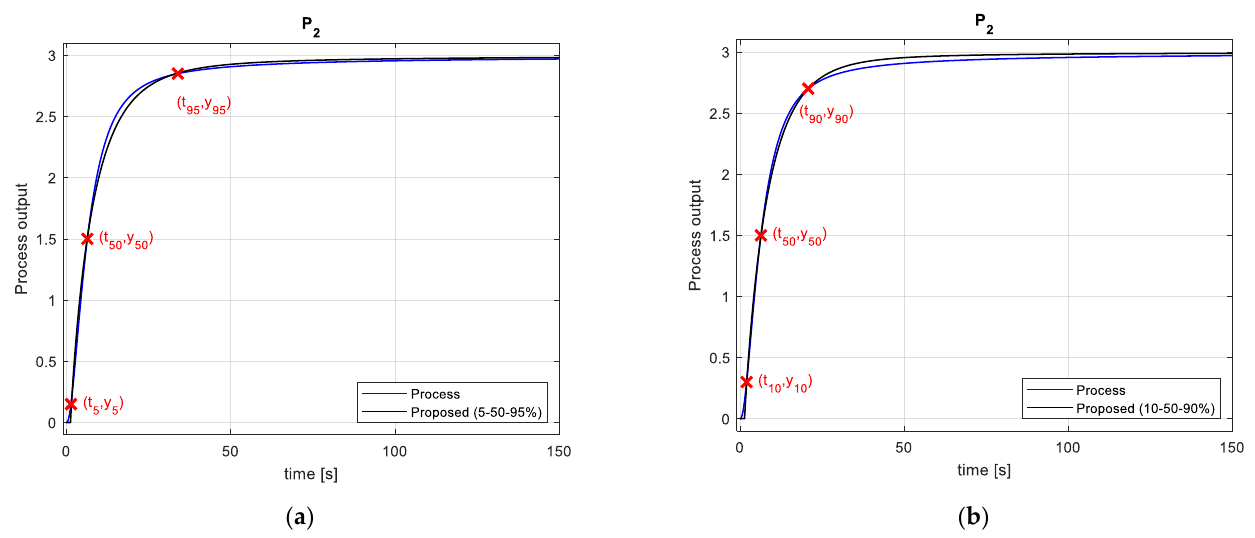
Figure 15. FFOPDT model step response using the proposed identification method for process P 2 and process reaction curve: ( a ) Symmetrical set of points (5-50-95%); ( b ) Symmetrical set of points (10-50-90%).